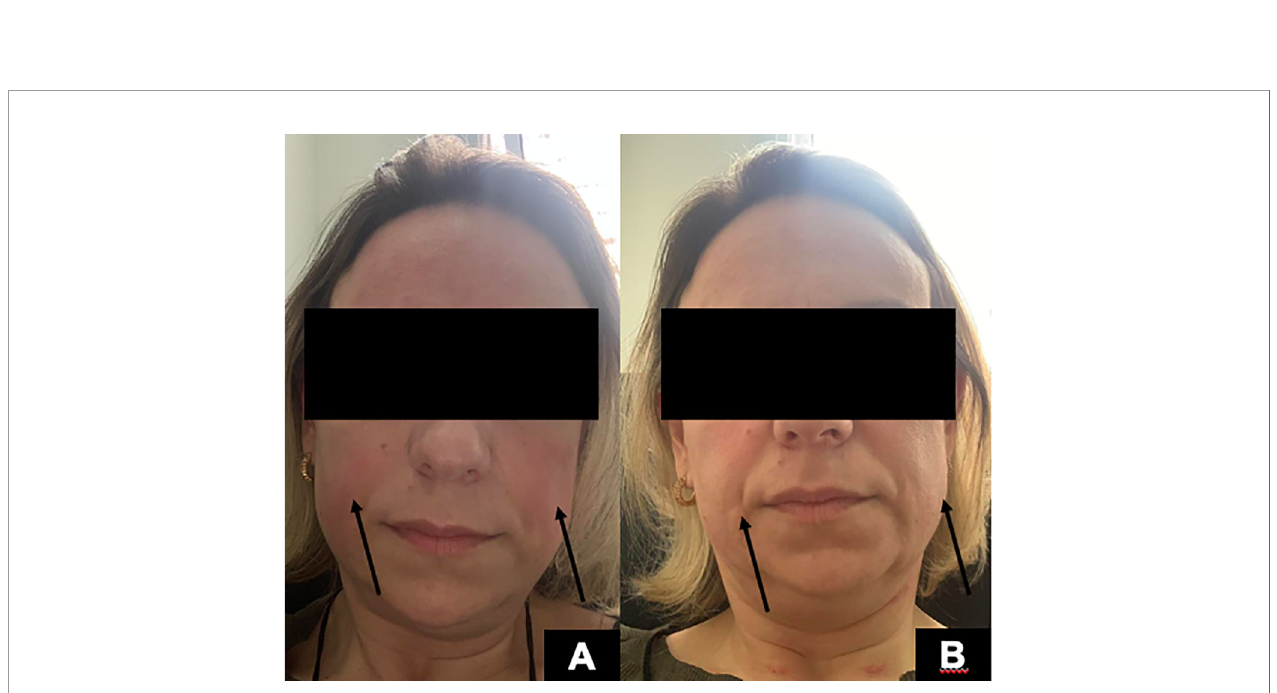
FIGURE 2 | (A) Facial erythema and fl ushing (arrows) during Ocrelizumab infusion. (B) Facial angioedema (arrows) minutes after the initial facial erythema.